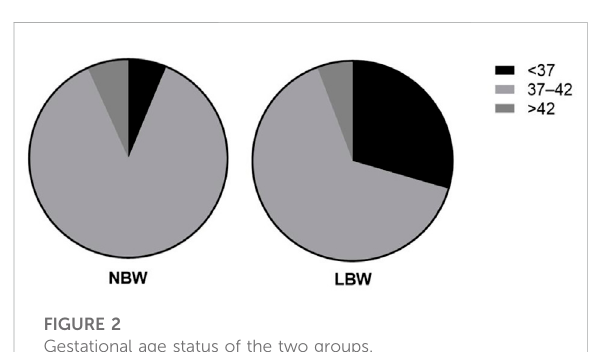
FIGURE 2 Gestational age status of the two groups.